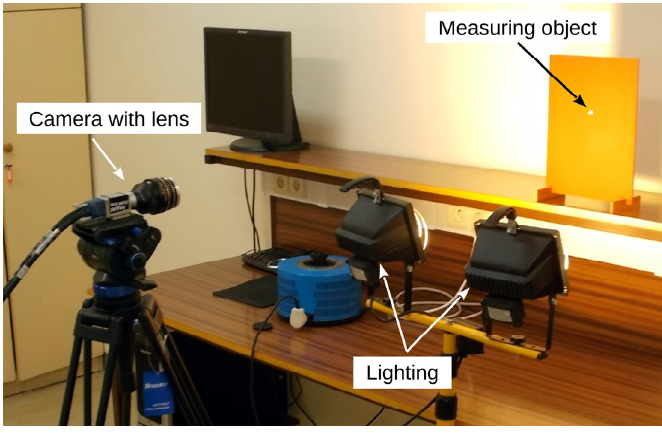
Figure 3. View of measuring stand.